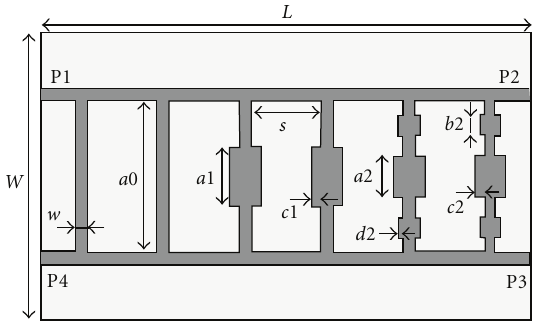
Figure 1: Profile of the UWB microstrip branch line coupler which consists of 2 × ordinary, 2 × first-order, and 2 × second-order Minkowski fractal branches.